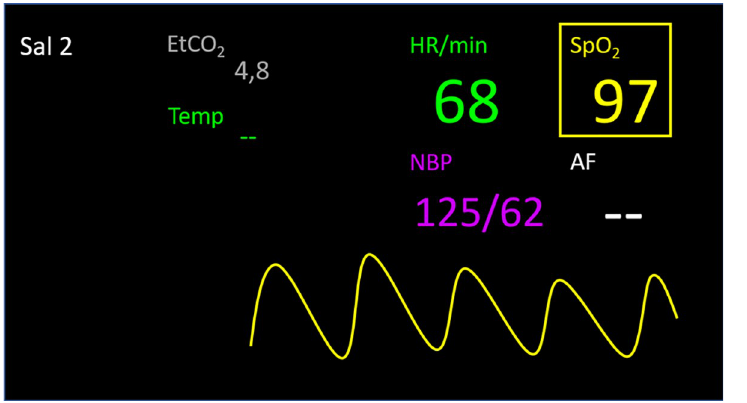
Fig 3. Example view of vital signs and associated oxygen saturation curve (yellow) in smart glasses. End tidal carbon dioxide (EtCO 2 ) in grey; heart rate (HR) in green; oxygen saturation (SpO 2 ) in yellow (the square around it indicates that the parameter is also being presented by an associated curve); and non-invasive blood pressure (NBP) in purple (invasive blood pressure would have been presented in red). Temperature (Temp) and breathing frequency (AF) are not shown in this application version. Sal 2 indicates the current operating room.